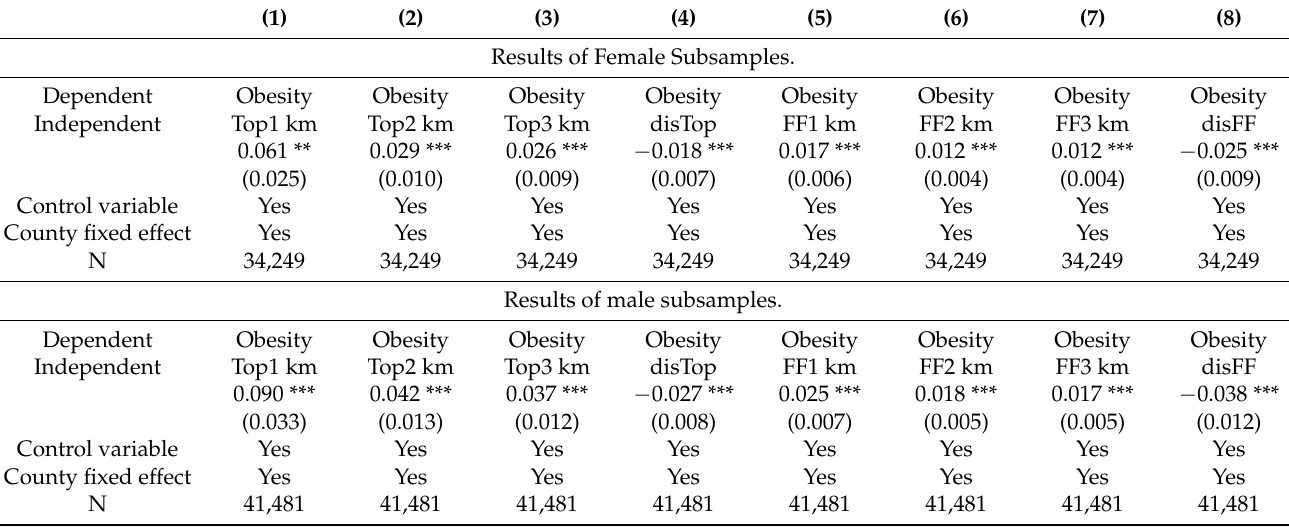
Table 7. Female and male